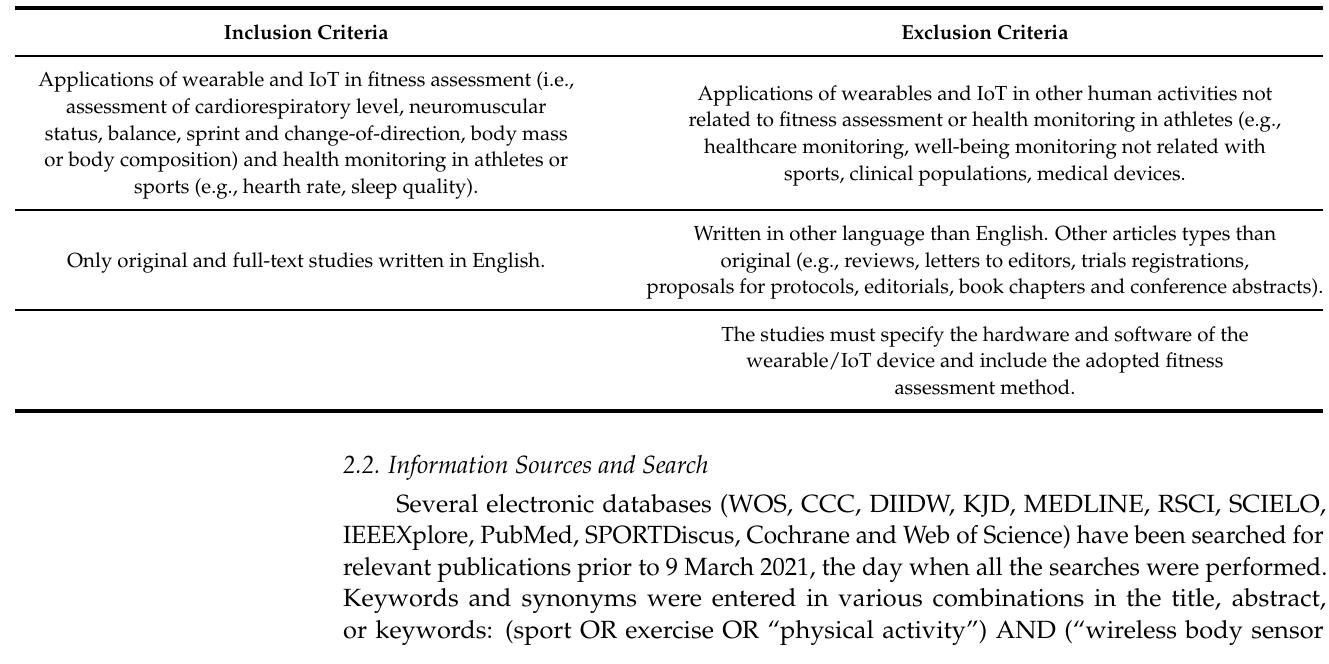
Table 1. Eligibility